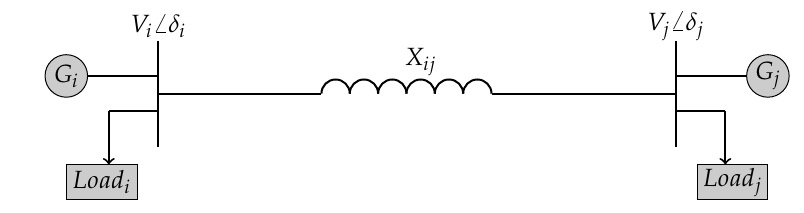
Figure 2. Tie-line interconnection of two-area system.